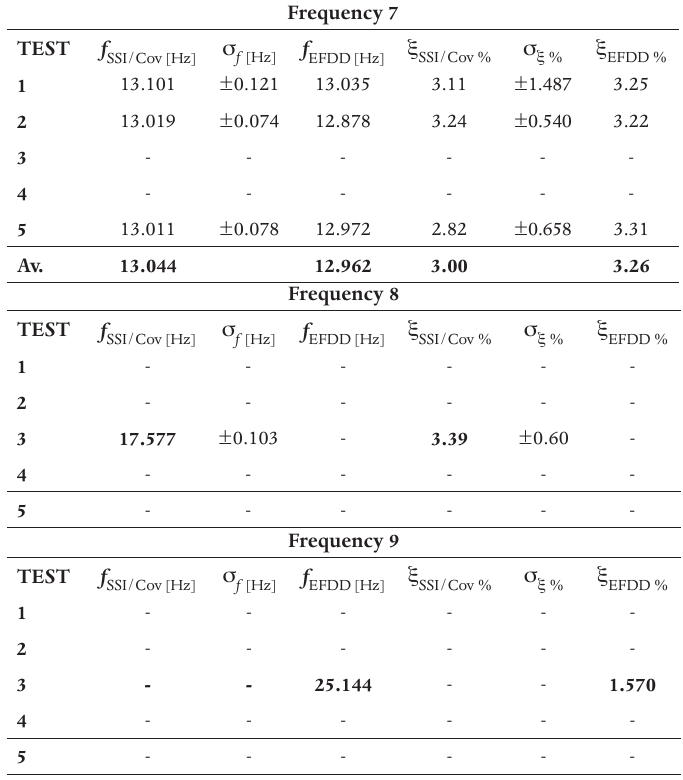
Table 1. Natural frequencies and modal damping ratios evaluated via the SSI/Cov and the EFDD methods.